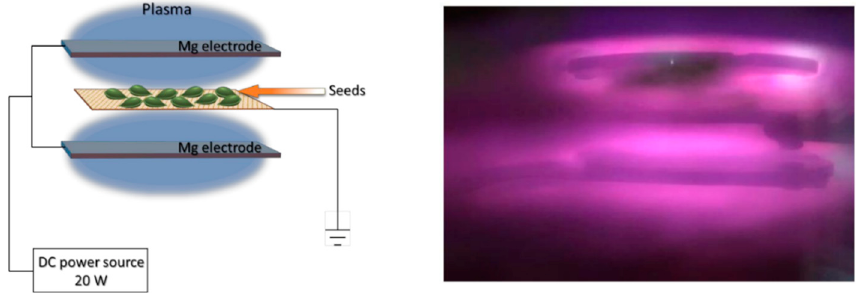
Figure 1. Experimental setup of seeds plasma treatment.